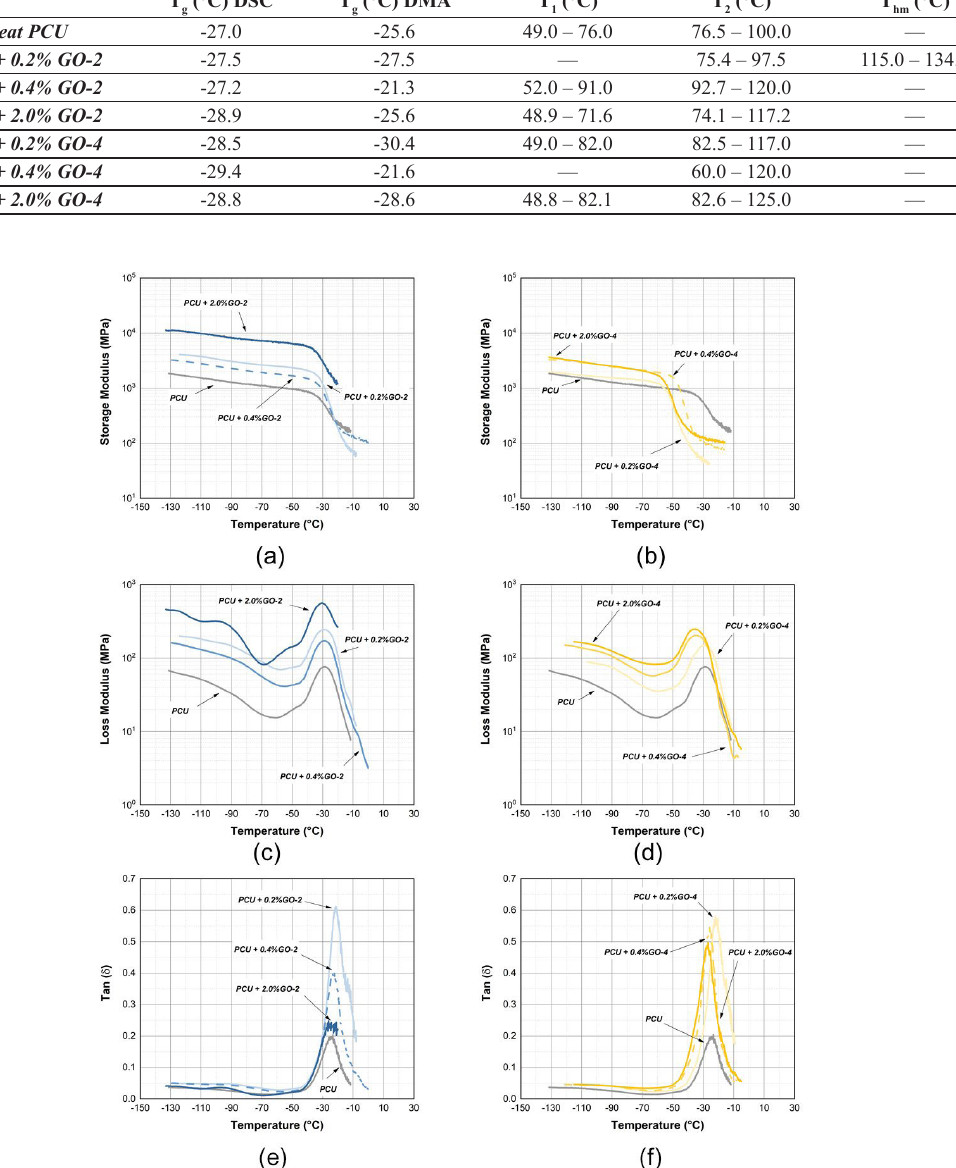
Table 3. Thermal properties for neat PCU and its nanocomposites, measured using DSC and DMA. Sample